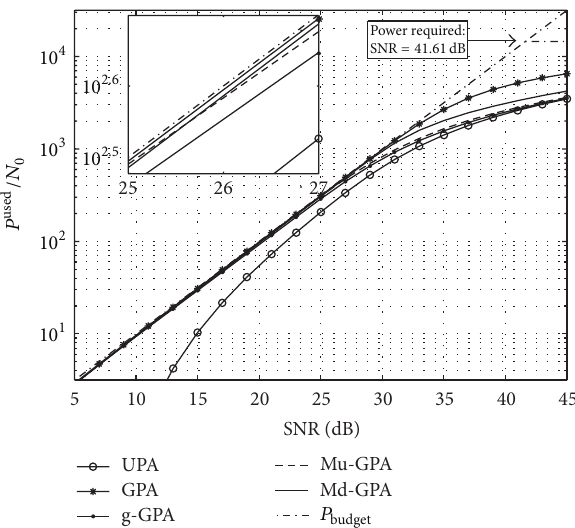
Figure 7: Power used by the considered algorithms for a 32- subcarrier system to achieve their respective throughput in Figure